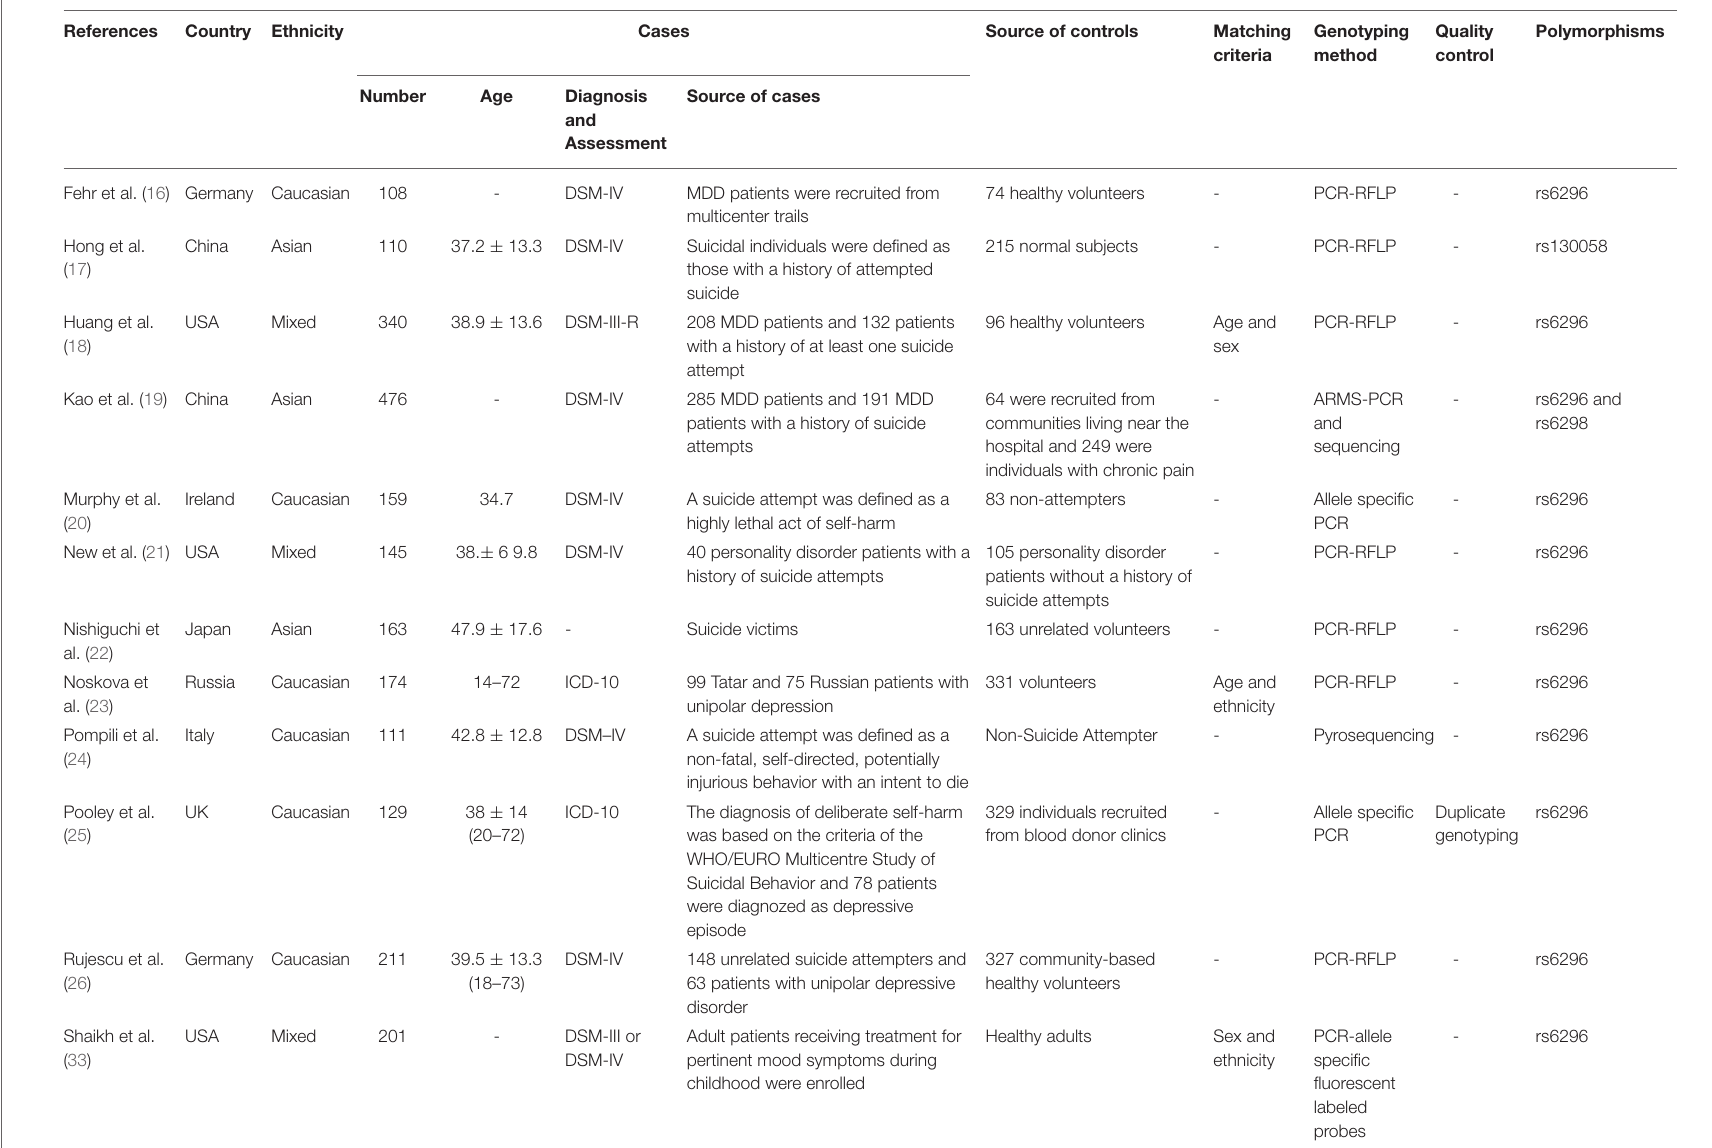
TABLE 1 | Characteristics of literatures included in the